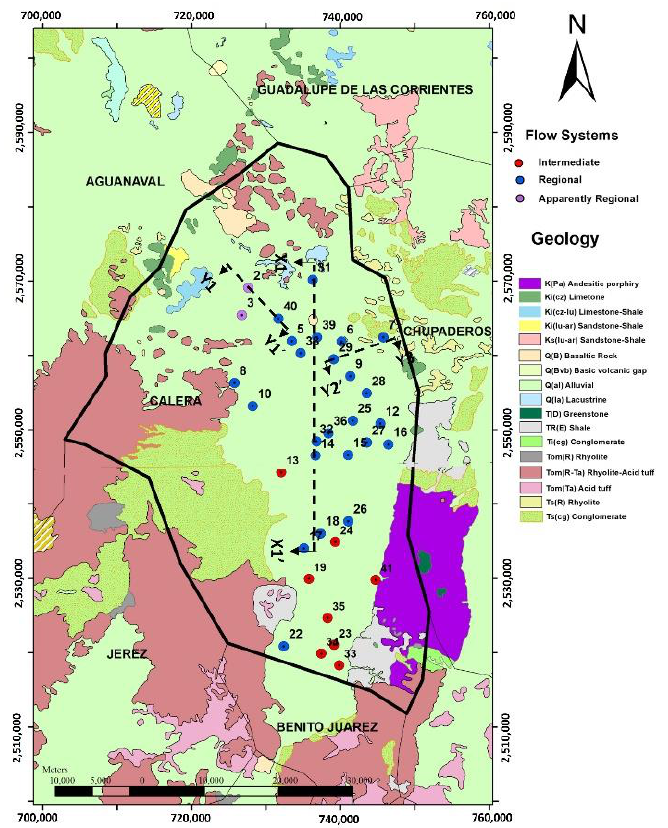
Figure 5. Groundwater flow systems identified at each well using cluster analysis (2020).